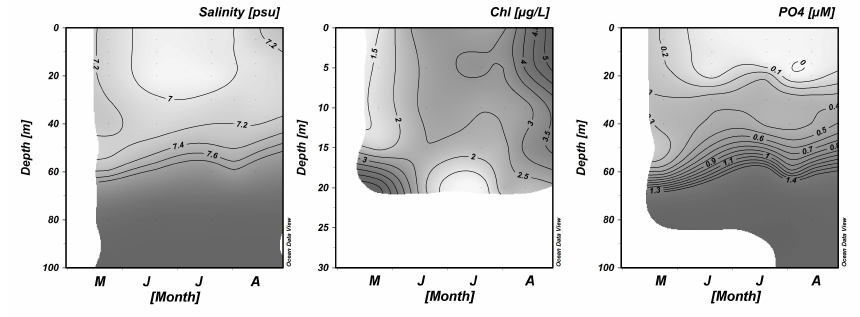
Fig. 12. Time series of salinity, density, chl- a and PO 2 − scale. This figure was prepared with Ocean Data View using DIVA